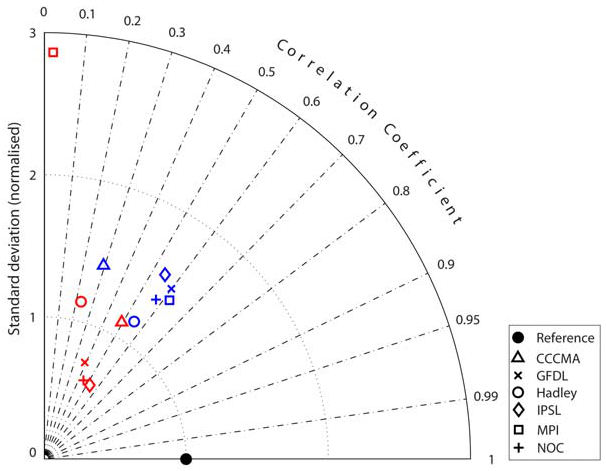
Figure 1 : Taylor diagram showing model-data comparison of global spatial Fig. 1. Taylor diagram showing model–data comparison of global spatial variability in seasonal amplitude of PP (red) and timing of variability in seasonal amplitude of PP (red) and timing of peak PP (blue) for 6 peak PP (blue) for 6 models. Model hindcast runs averaged from 1985–2005 are compared with satellite-derived data averaged from models. Model hindcast runs averaged from 1985-2005 are compared with satellite- 1998–2007. Taylor diagrams compare the correlation coefficient of derived data averaged from 1998-2007. Taylor diagrams compare the correlation the data and model and the normalised model standard deviation (model standard deviation/data standard deviation). A perfect model coefficient of the data and model and the normalised model standard deviation (model has a correlation coefficient of 1 and normalised standard deviation standard deviation/data standard deviation). A perfect model has a correlation of 1 (indicated by the black reference circle). coefficient of 1 and normalised standard deviation of 1 (indicated by the black reference circle).